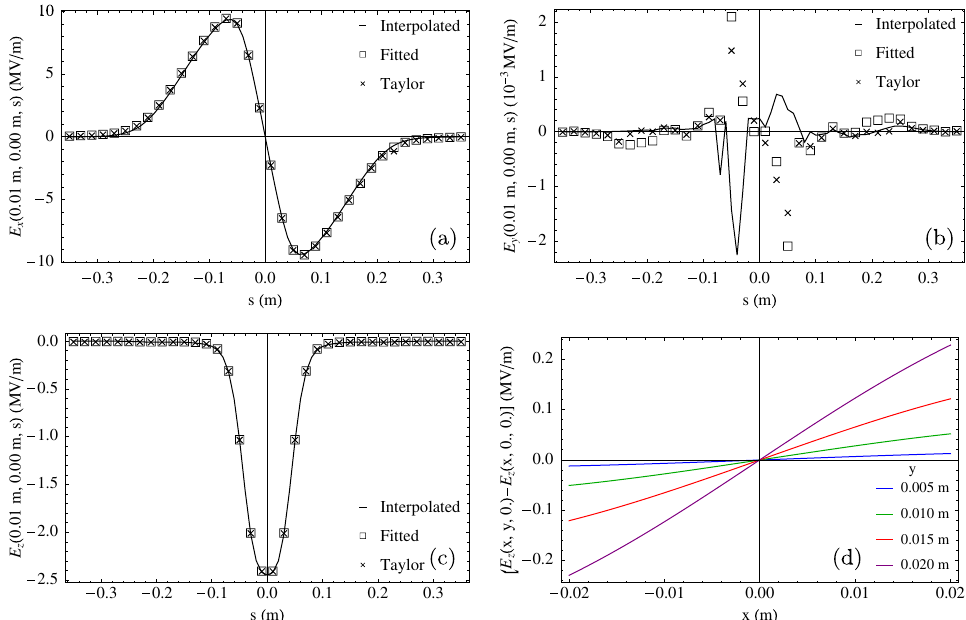
FIG. 3. E fields with varying s at x ¼ 0 . 01 m and y ¼ 0 . 00 m. (a) E x , (b) E y , and (c) E z . The Interpolated mesh fields and Fitted and Taylor analytical representations are shown. (d) E z transverse variation in x and y away from variation at y ¼ 0 m from Taylor